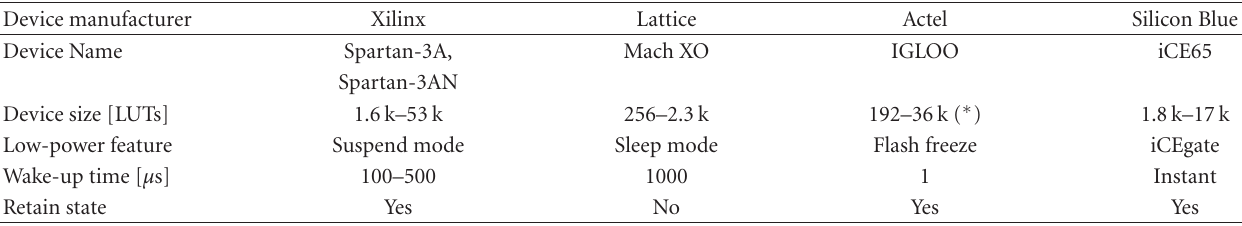
Table 1: Comparison of devices and low-power